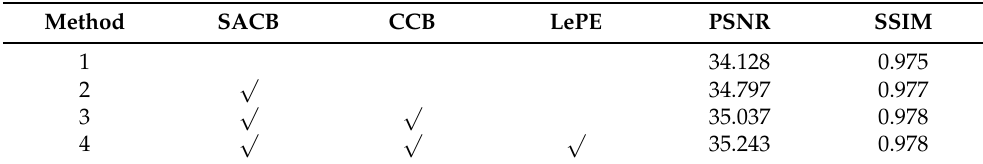
Table 1. PSNR and SSIM on RICE1 test set with different